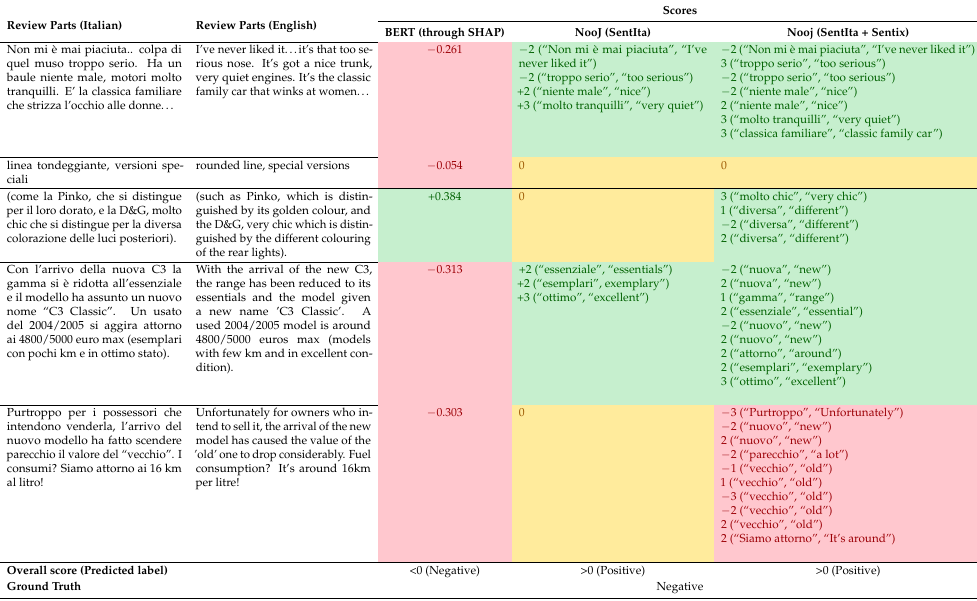
Table 9. Only BERT detects them correctly. Example A.